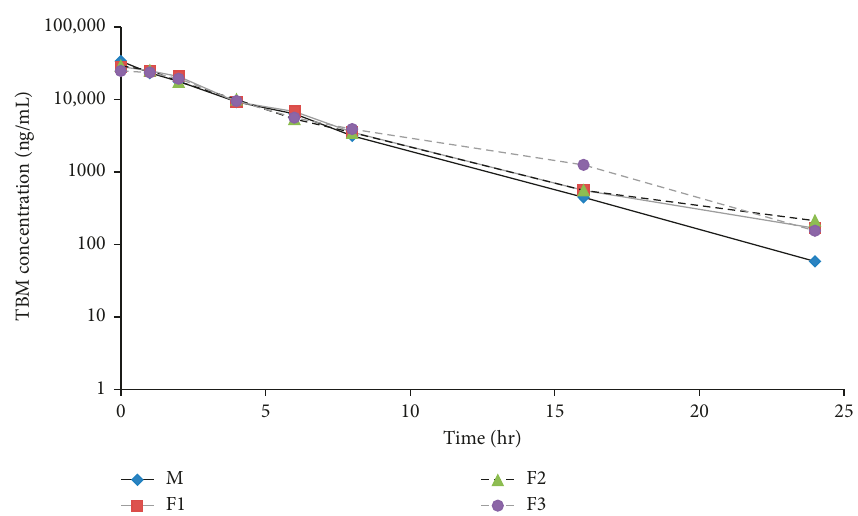
Figure 4: Concentration-time profile of tobramycin from an in vitro PK/PD biofilm model. Samples were taken from the feeding bottle (M) and the tubing outlets from three flow cells with bacterial biofilm (F1, F2, and F3) at designated time